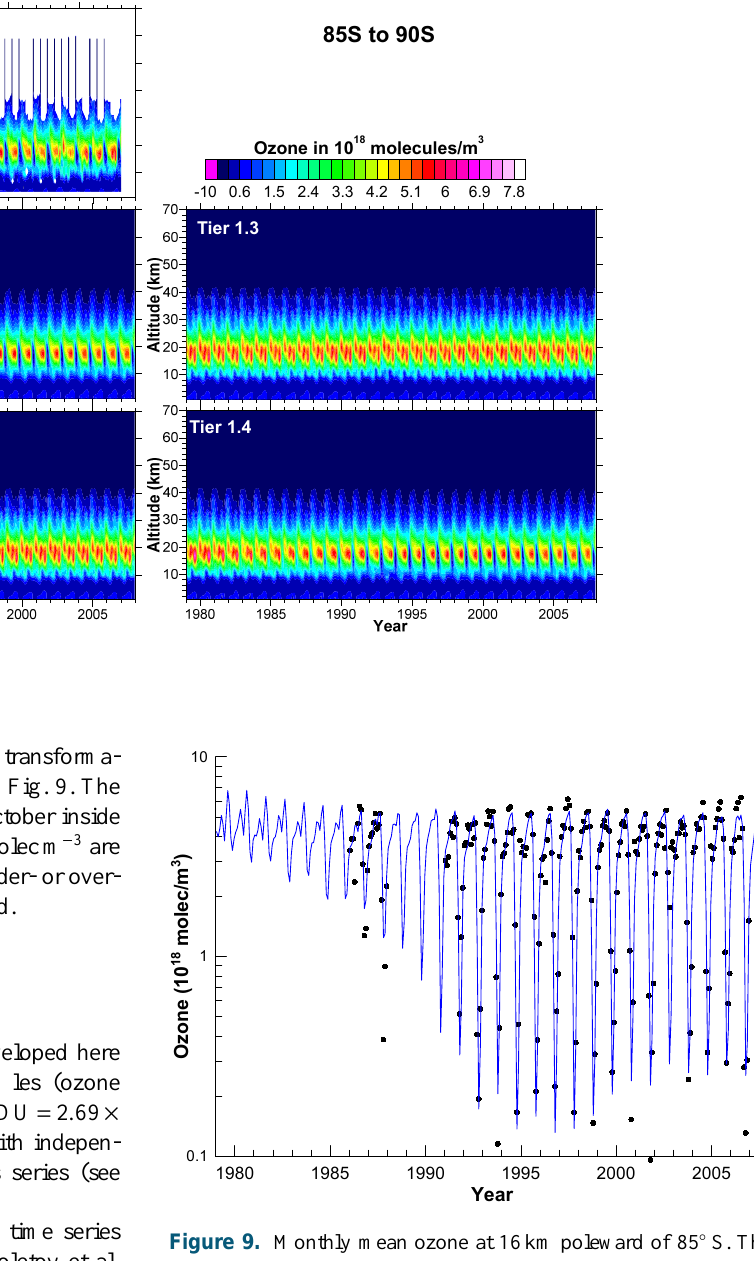
Figure 9. Monthly mean ozone at 16km poleward of 85 ◦ S. The Fig. 9. Monthly mean ozone at 16km poleward of 85 ◦ S. The Tier 0 monthly means are shown as black dots Tier 0 monthly means are shown as black dots while the Tier 1.4 Fig. 9. Monthly mean ozone at 16 km poleward of 85 ◦ S. The Tier 0 monthly means are shown as black dots while the Tier 1.4 reconstruction is shown as a blue line. reconstruction is shown as a blue while the Tier 1.4 reconstruction is shown as a blue line.